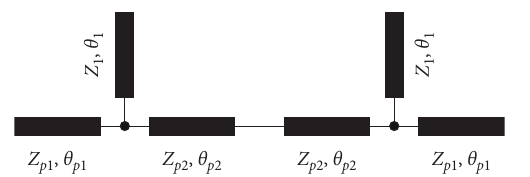
Figure 1: *e proposed symmetrical branch loaded resonator.